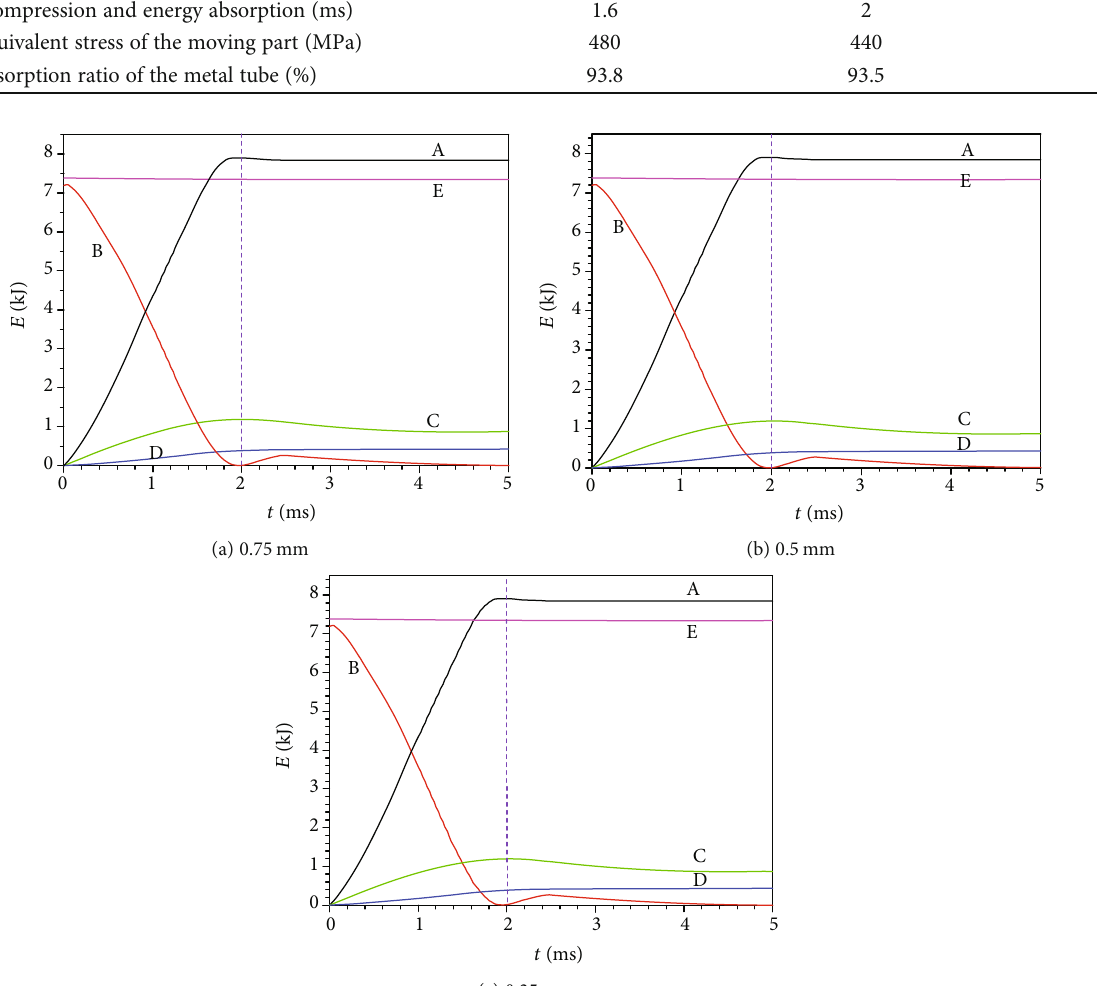
Table 3: Simulation results: compression and energy absorption parameters of metal tubes of di ff erent wall thicknesses. Wall thickness of the metal tube D (mm)